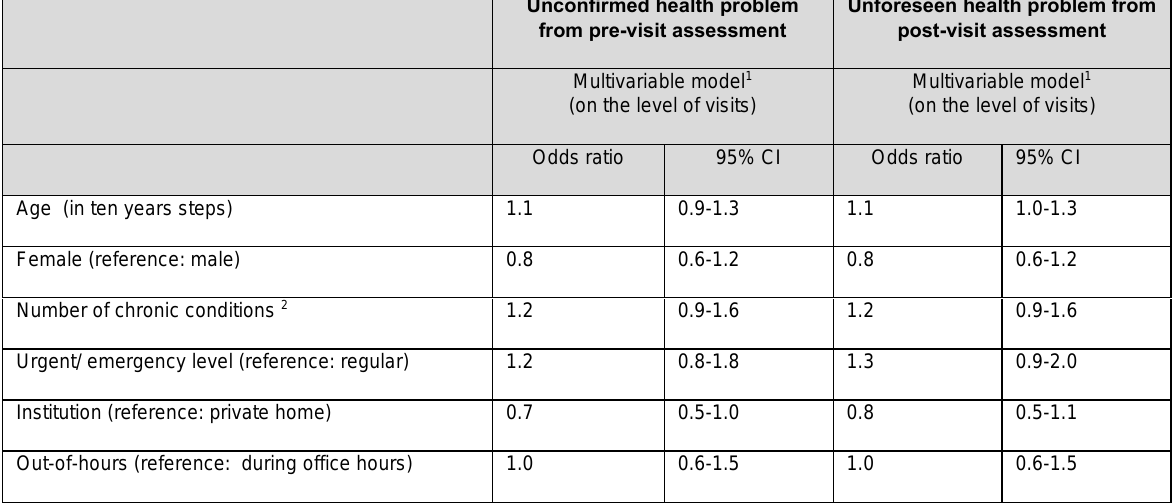
Table S 4: A ssociations of possible red flags w ith unconfirmed and unforeseen health problems, on the level of